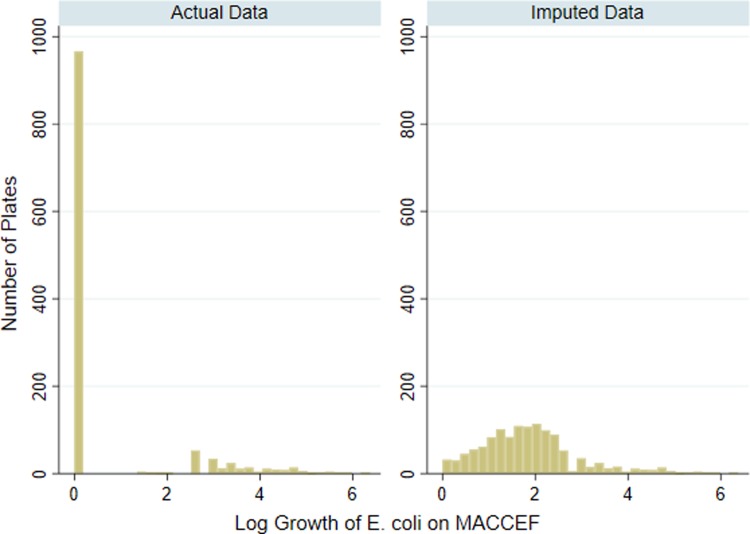
Visual representation of actual versus imputed third-generation cephalosporin resistant E. coli growth.a) Actual log10 CFU E. coli growth on MacConkey agar prepared with ceftriaxone (4μg/mL), b) Example of imputed log10 CFU E. coli growth on MacConkey agar prepared with ceftriaxone at 4μg/mL using multiple imputation procedures for values estimated below the limit of quantification.